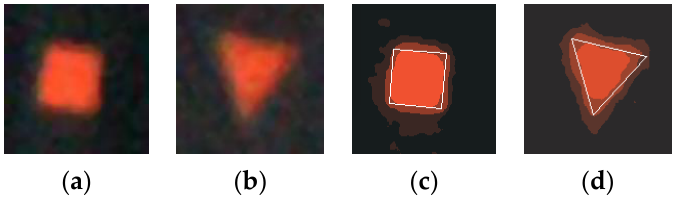
Figure 10. The segmenting results of square and triangle mark points: ( a ) A square marking point, ( b ) A triangle marking point, ( c ) The segmenting result of square mark point, and ( d ) The segmenting result of triangle mark point.